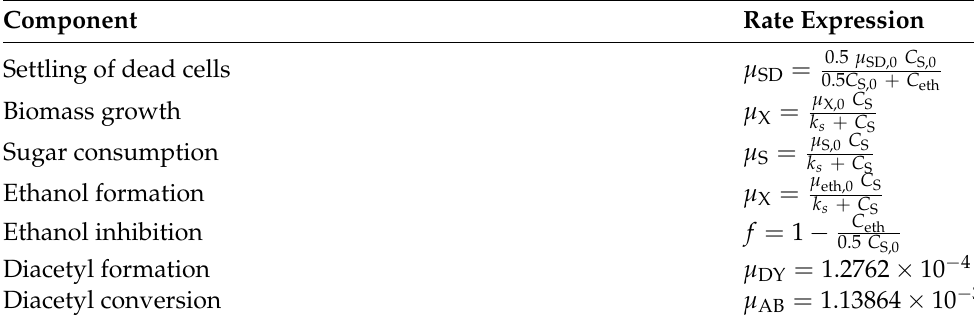
Table 1. Rate expressions used in the dynamic model.